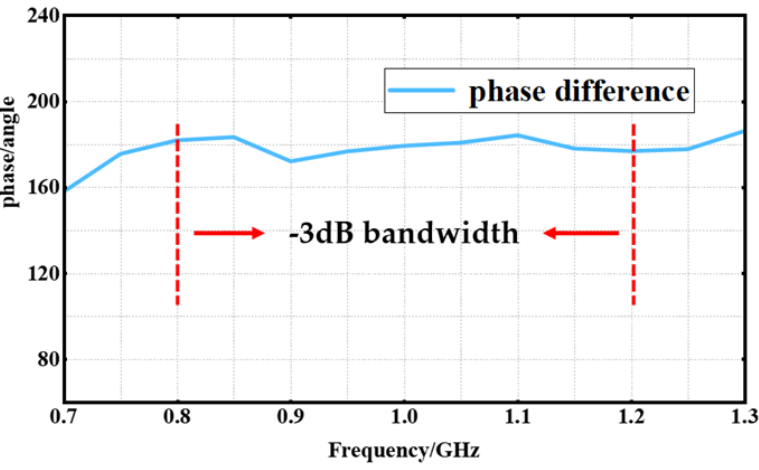
Figure 6. The phase difference between the forward and the reverse transmissions.